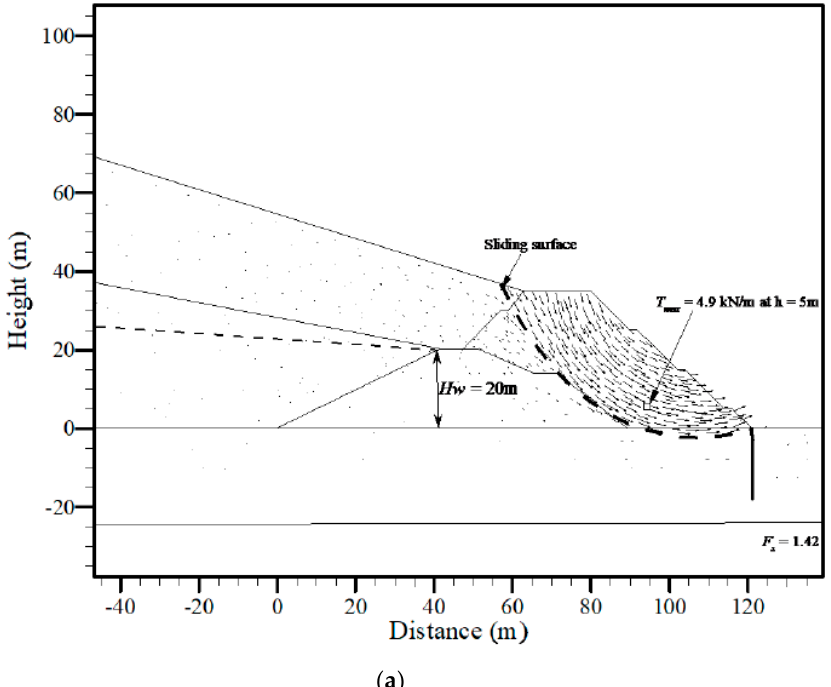
Table 2. Parametric study performed on the GRS berm.